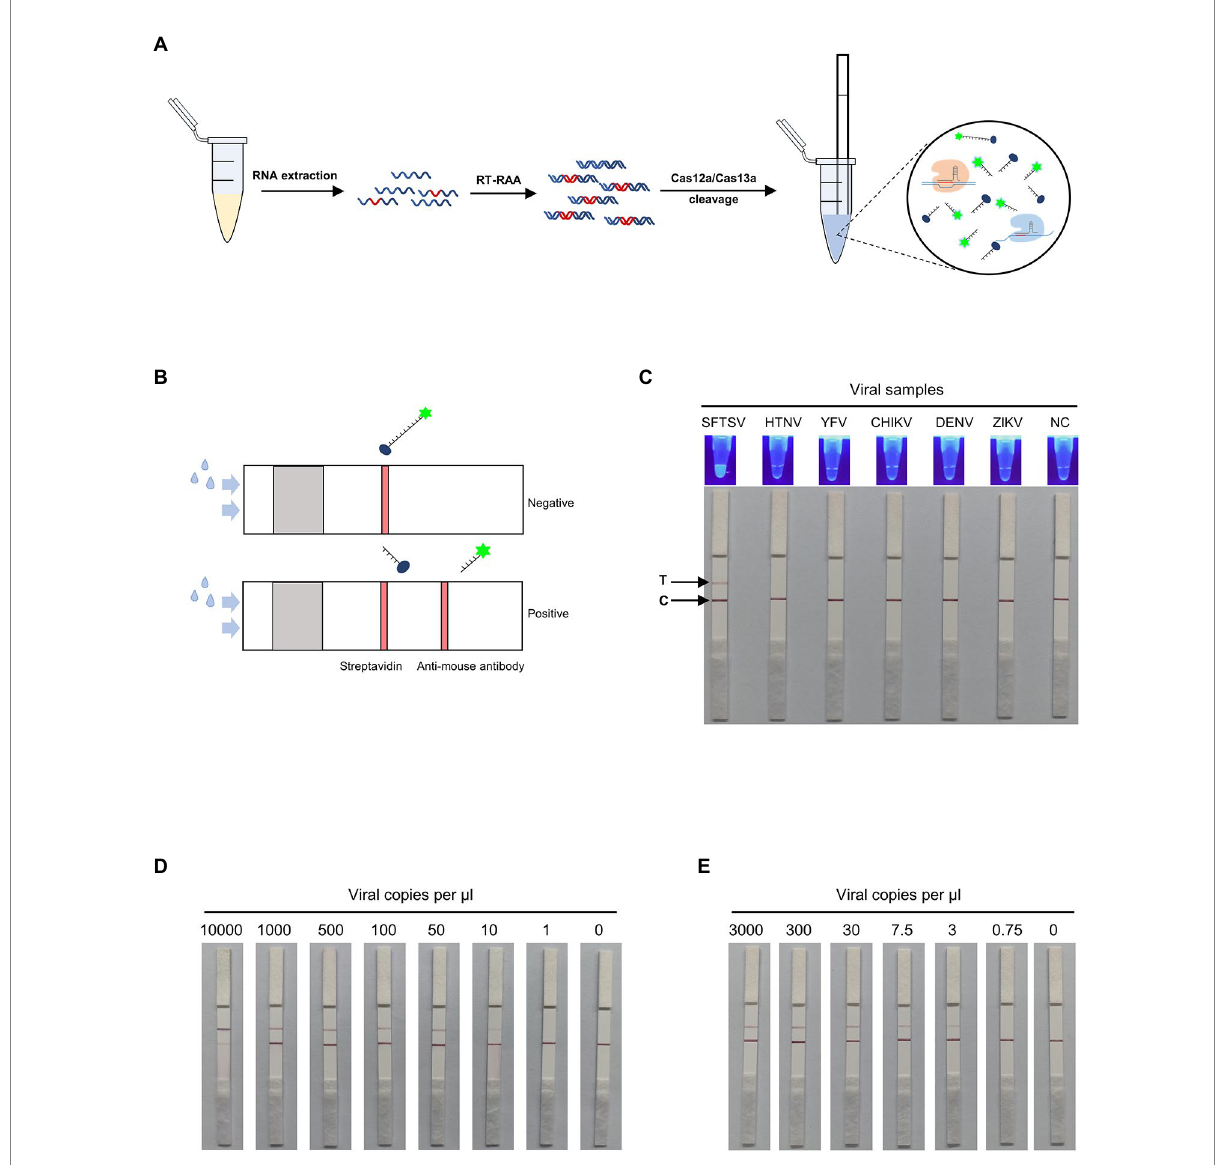
FIGURE 4 SFTSV nucleic acid detection combined with immunochromatography. (A) Workflow for the SFTSV RNA detection in clinical samples using CRISPR/Cas12a or Cas13a in combination with immunochromatographic strips. (B) Schematic of the fluorescent version of Cas12a/Cas13a-based assay coupled with lateral flow detection. The intact ssDNA/ssRNA reporter labeled FAM and biotin flows to the control capture line. When the ssDNA/ssRNA reporter was cleaved by activated Cas12a/Cas13a, the cleaved reporter flows to the target capture line. (C) The specificity of fluorescence visualization and lateral flow detection based on CRISPR/Cas12a assay for SFTSV. The top line is the test line, and the bottom line is the control line. The color change at the test line was only observed for SFTSV detection. (D) The detection limit of the single-target test strip based on CRISPR/Cas12a assay using Cas12-M-crRNA8. (E) The detection limit of the single-target test strip based on CRISPR/Cas13a assay using